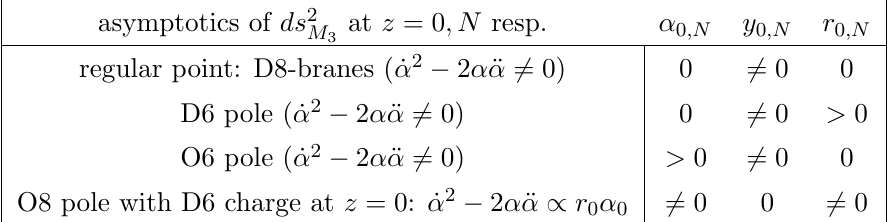
Table 2. The requirements for having a regular point, a D6 or D6-O6 (cid:6) source, a D8-O8 source with (smeared) D6 charge at the poles of the supergravity solution, characterized by an internal space S 2 , M 3 I = [0 ; N ] (or RP 2 , M 3 I = [0 ; N ]). Di(cid:11)erent sources impose di(cid:11)erent ! ! ! ! boundary conditions on the metric of M 3 at the extrema of the base interval I . Notice that we can have an O8-plane only at z = 0. The former acts as a mirror along direction z , and we choose to parameterize the physical half of the space by z [0 ; N 2